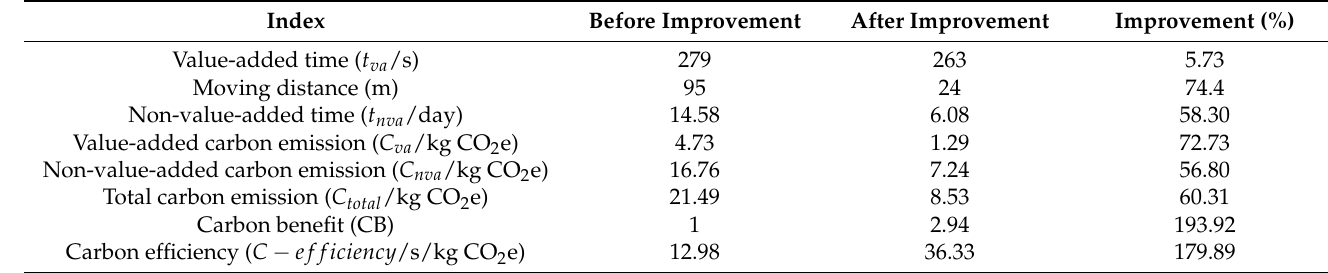
Table 1. The result of satellite dish kit production line before and after